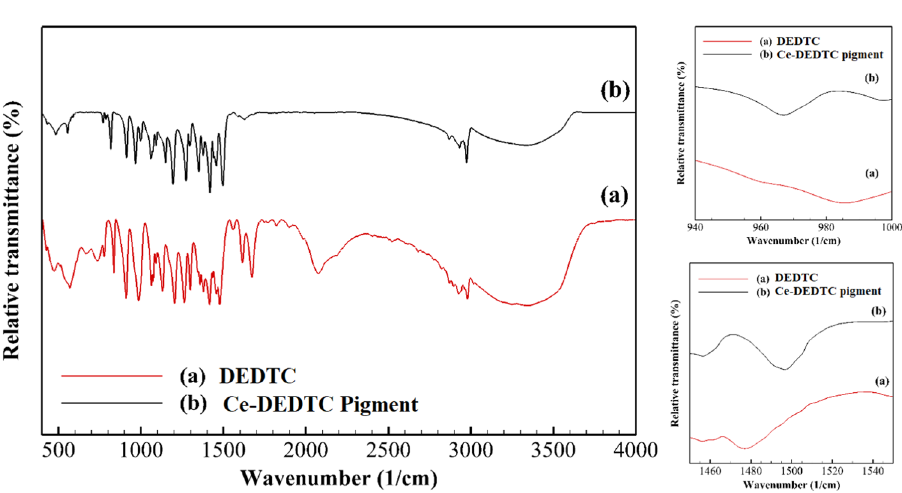
Figure 2. FT-IR spectra of the parent DEDTC and Ce-DEDTC